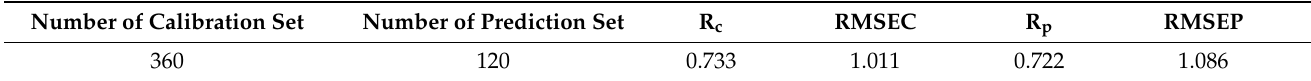
Table 2. PLSR findings for SSC of mixed apple size